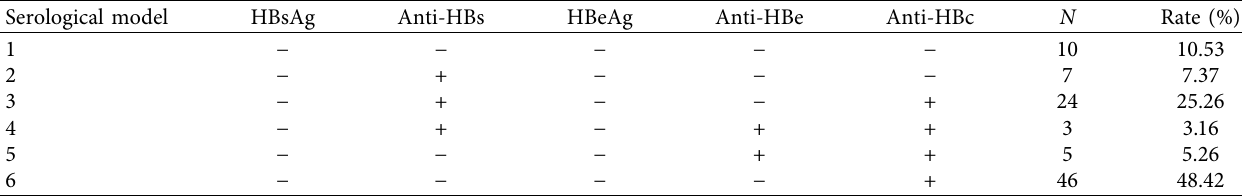
Table 1: The serological classification of HBsAg ( − )/HBV DNA (+) samples.